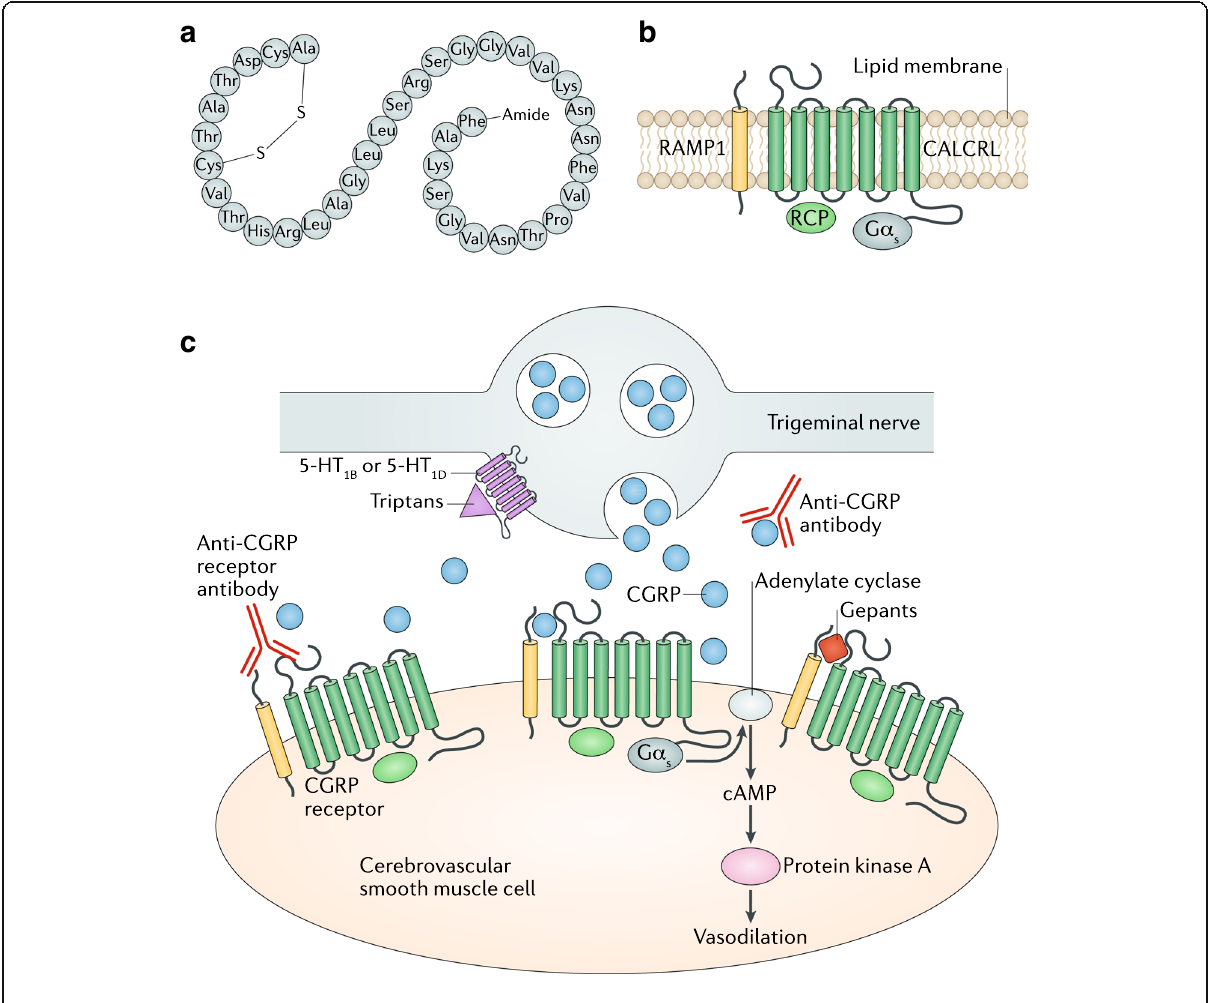
Fig. 1 The overall picture on how the new era of CGRP pathway interacting molecules is given below. These drugs are designer molecules that have been constructed as anti-migraine